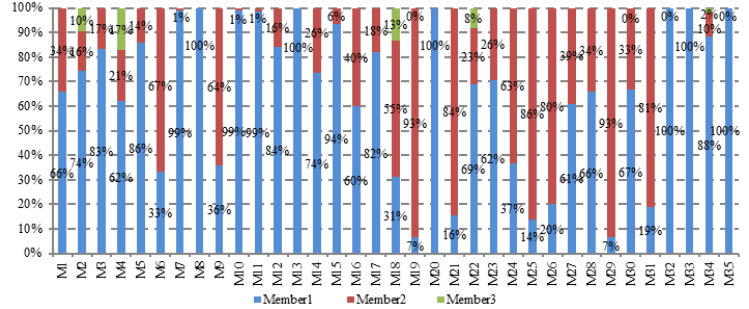
Fig. 2. Distribution of editing actions among group members for each group of students of the